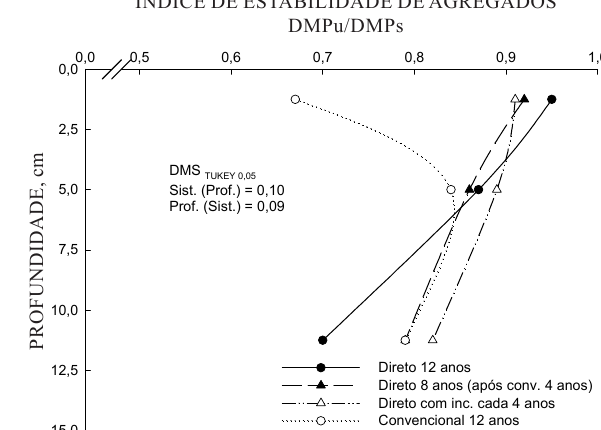
Figura 4. Microporosidade do solo em diferentes sistemas de manejo e